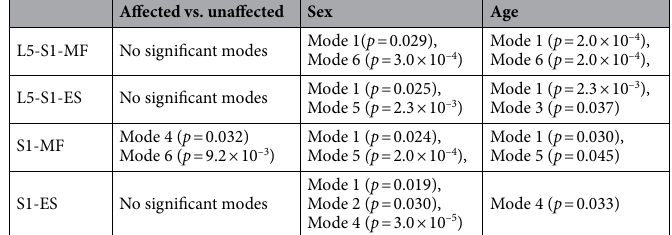
Table 3. Significant modes (shape variations) of each muscle group with respect to different factors ( p < 0.05).